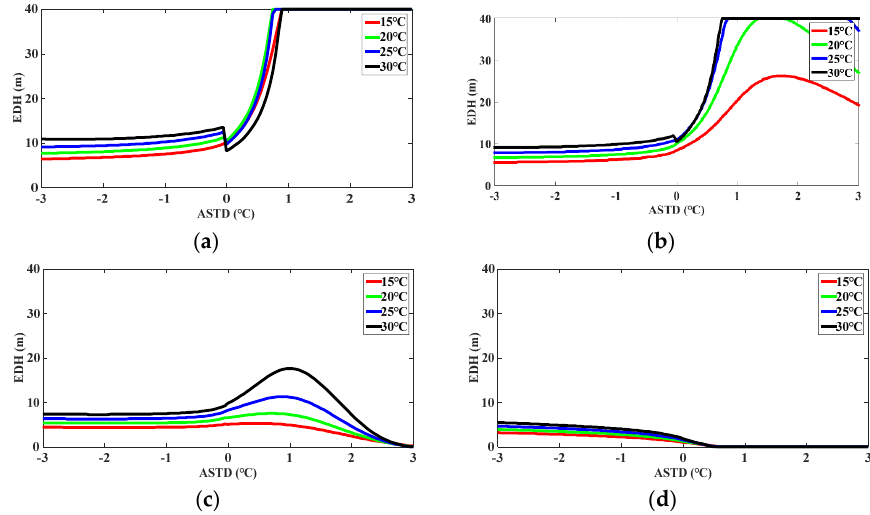
Figure 12. The predicted value of EDH according to the NAF model. The AT of 15 °C, 20 °C, 25 °C, and 30 °C are represented by the red solid line, green solid line, blue solid line, and black solid line, respectively. The WS was fixed at 5 m/s. The RH was set at 65%, 75%, 85%, and 95% according to ( a – d ), respectively.